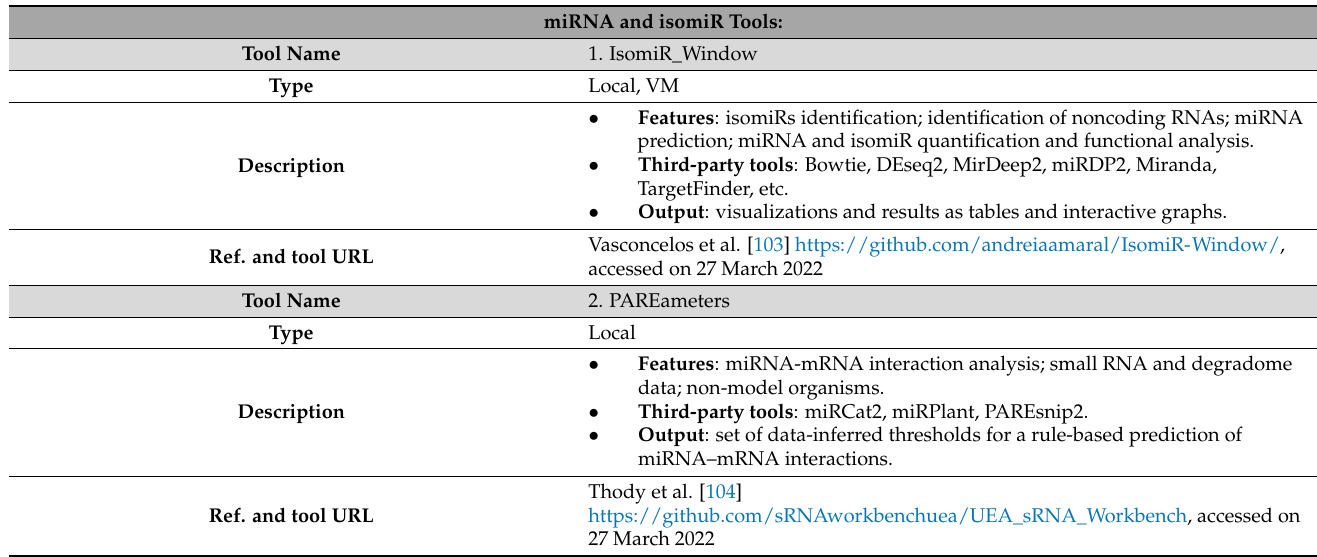
Table 1. List of bioinformatics tools for plant small RNA analysis and their main features. miRNA and isomiR